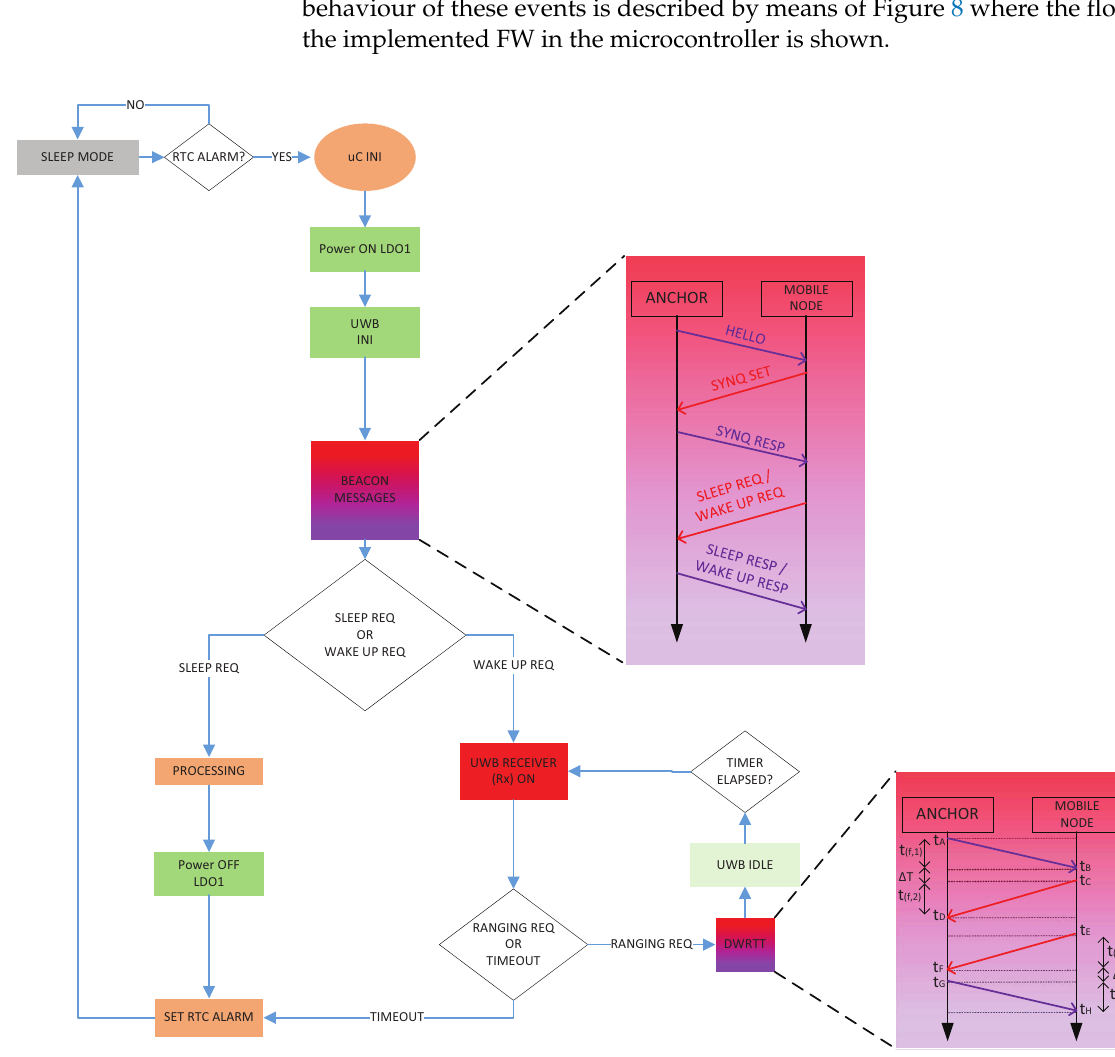
Figure 8. UWB Anchor flow